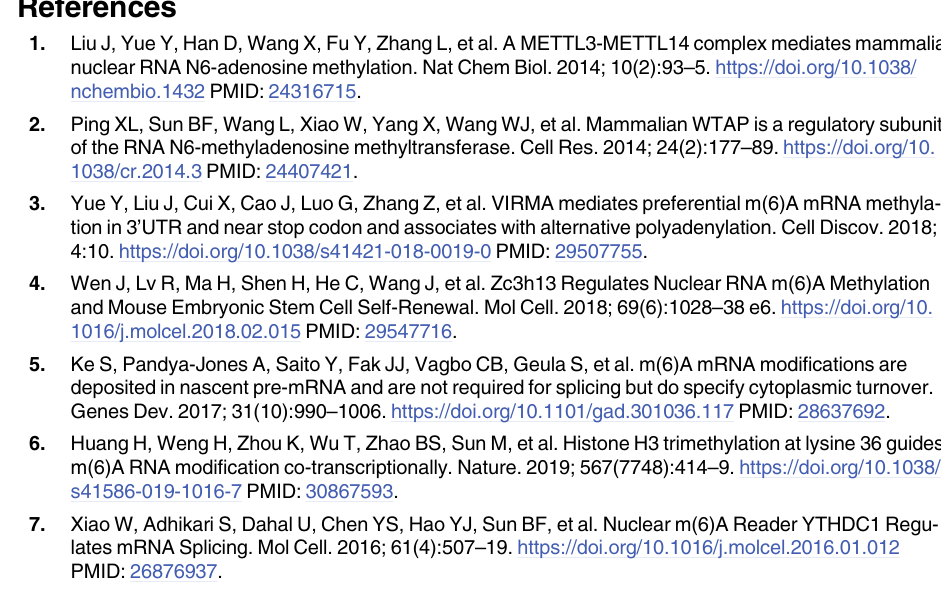
S1 Table. m6A peaks at different phases of the cell cycle. S2 Table. Differential analysis of peak enrichment. S3 Table. High-confidence YTHDF2 target genes. S4 Table. Expression levels of phase-specific genes. S5 Table. Oligos and reagents used in this